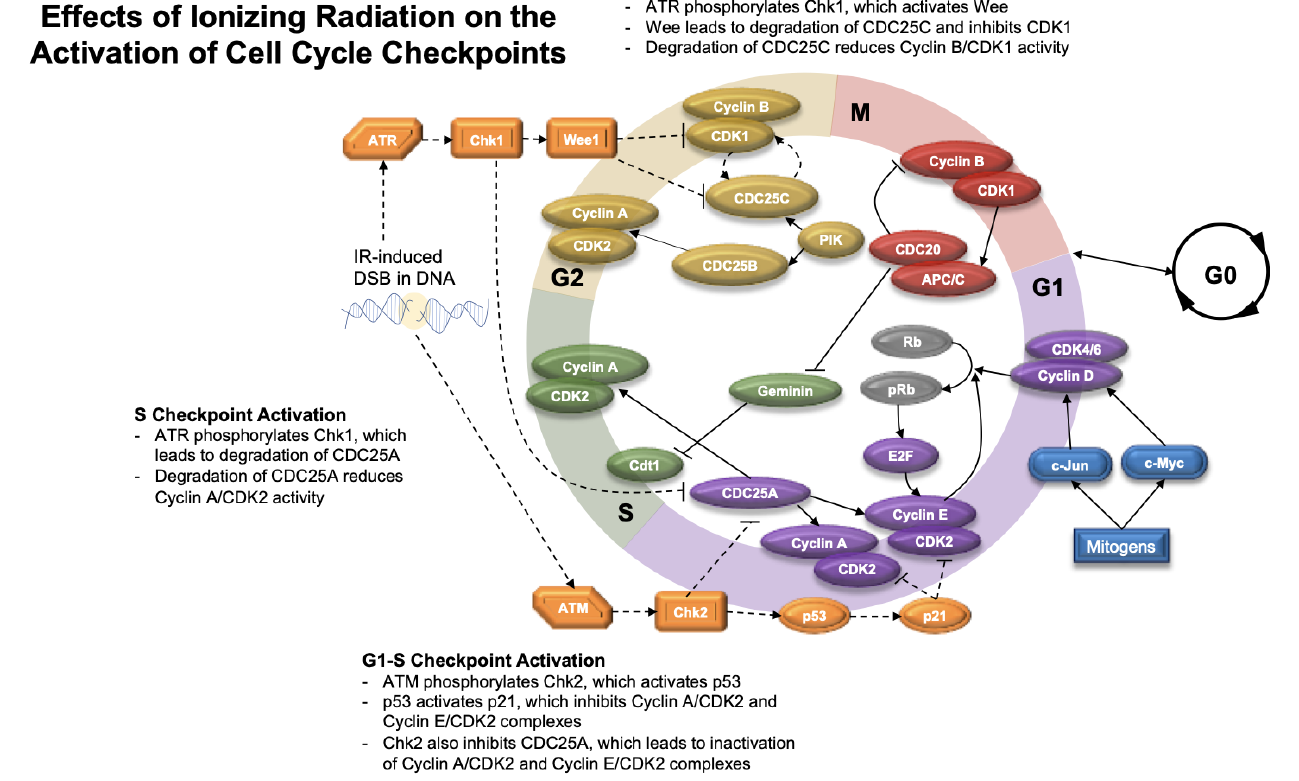
Figure 5. Diagram of radiation effects on the cell cycle. This diagram shows how ionizing radiation (IR)-induced double- stranded DNA breaks (DSB) initiate ATR (Ataxia-telangiectasia and Rad3 related protein) and ATM (ataxia-telangiectasia mutated) mediated activation of Chk1 (checkpoint protein 1) and Chk2 (checkpoint protein 2) protein kinases, respectively. Activation of Chk1 and Chk2 protein kinases leads to downstream events that push cells into cell cycle arrest to allow for DNA repair to occur. Dotted lines indicate events associated with radiation-induced changes to the cell cycle. APC/C (anaphase promoting complex), CDC25 (cell division cycle 25), CDK1/2/4/6 (cyclin-dependent kinase 1/2/4/6), Cdt1 (chromatin licensing and DNA replicating factor 1), E2F (family of transcription factors), p21 (cyclin dependent kinase inhibitor 1), p53 (tumor protein p53), PIK (phosphatidylinositol kinase), pRB (phosphorylated retinoblastoma protein), Rb (retinoblastoma protein), Wee1 (Wee1-like checkpoint